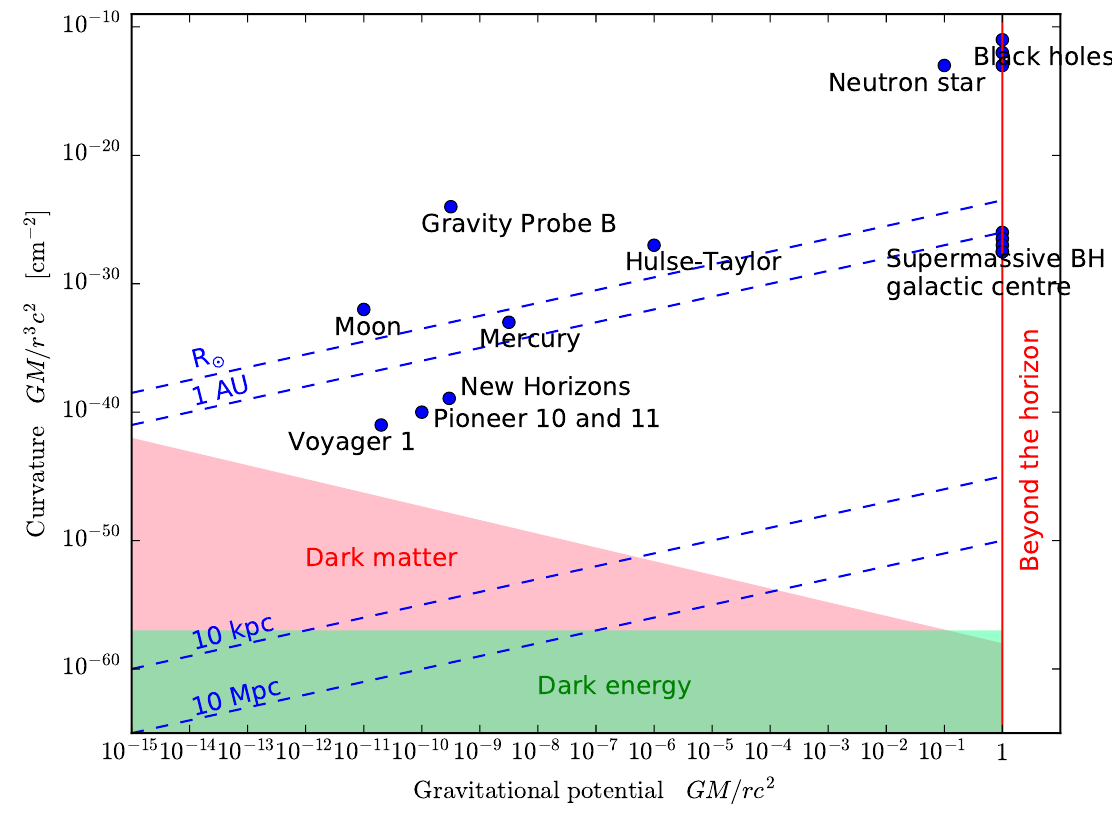
Figure 5. The parameter space for quantifying the strength of a gravitational field. The horizontal axis measures the potential. The vertical axis measures the spacetime curvature of the gravitational field at a radius r away from a central object of mass M . Regions of this parameter space with potential greater than 1 represent distances from a gravitating object that are smaller than the event horizon radius and are therefore inaccessible to observers. The red vertical line on the right-hand side of the plot marks the horizon limit. This is a schematic plot, and in no way do we show an exhaustive list of objects and systems that have been used or could be used to test GR. The region of Solar System-scale tests is broadly bounded by the Moon, Gravity probe B [406,407], Mercury, and the Pioneer and New Horizons spacecraft. We have included the Voyager spacecraft in the diagram, even though, unlike the Pioneer probe, it was never suitable for tests of GR. The famous Hulse-Taylor binary pulsar [408], although a neutron star binary, is also roughly in the region of Solar System tests. Black holes and neutron stars are in the strong field regime, and the former are at at the limit of the event horizon boundary. Adapted from